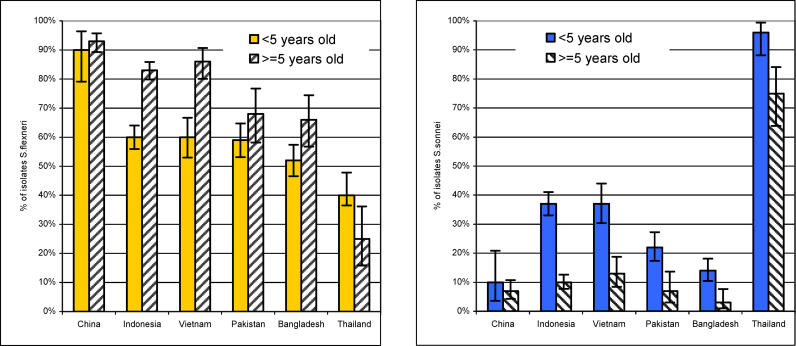
The Relative Distribution of S. flexneri and S. sonnei at Study Sites in Six Asian Countries
S. flexneri (left bar graph) was more frequently isolated from diarrhea patients 5 y and older (p < 0.0001). In contrast, S. sonnei (right bar graph) was more frequently isolated from children under 5 y of age (p < 0.0001).